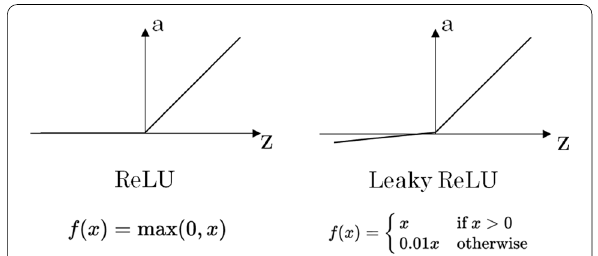
Fig. 11 ReLU and leaky ReLU activation